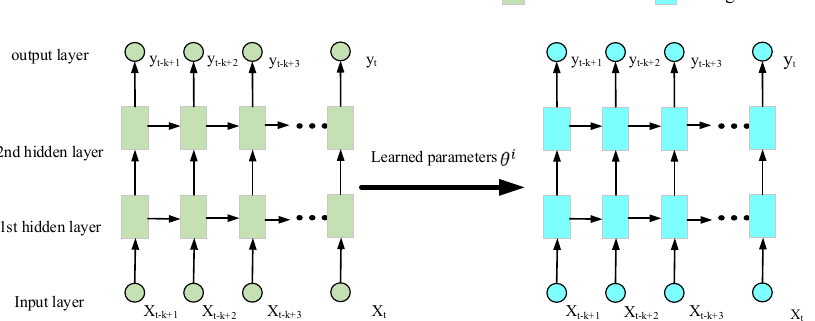
Figure 5. The process of transfer